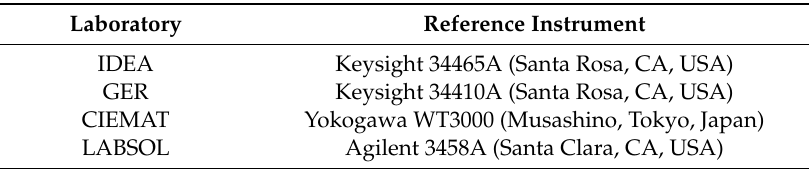
Table 4. Reference system used in each